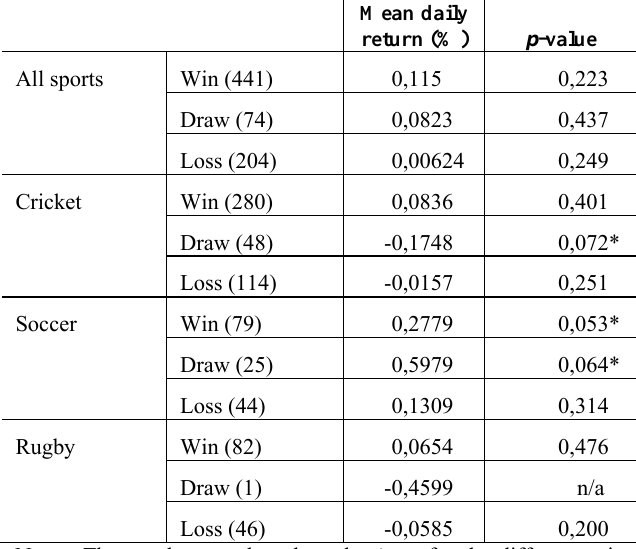
Table 3: Results of t-tests for the difference in